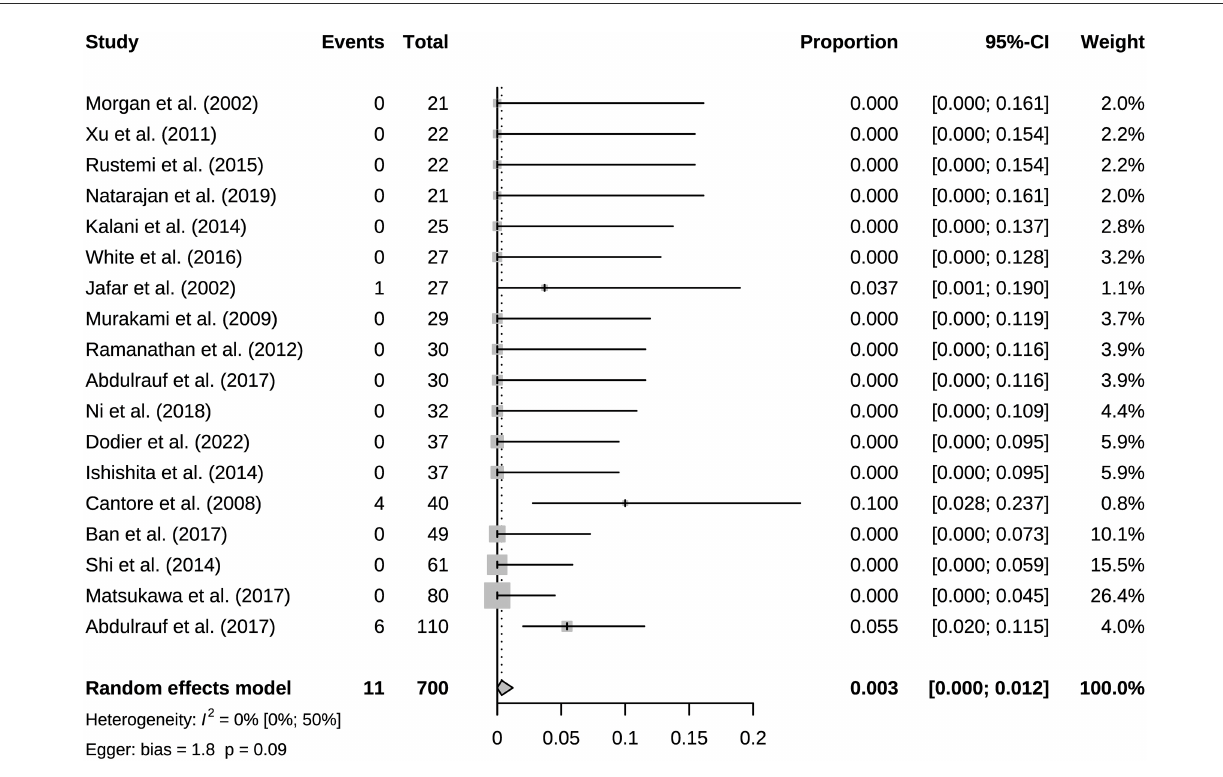
(Figure 5). The long-term pooled patency rates of high-flow, low- flow, SVG and RAG were 95%, 96%, 93%, and 96% respectively (Supplementary Figures S2–S5). A total of 18 studies were pooled,